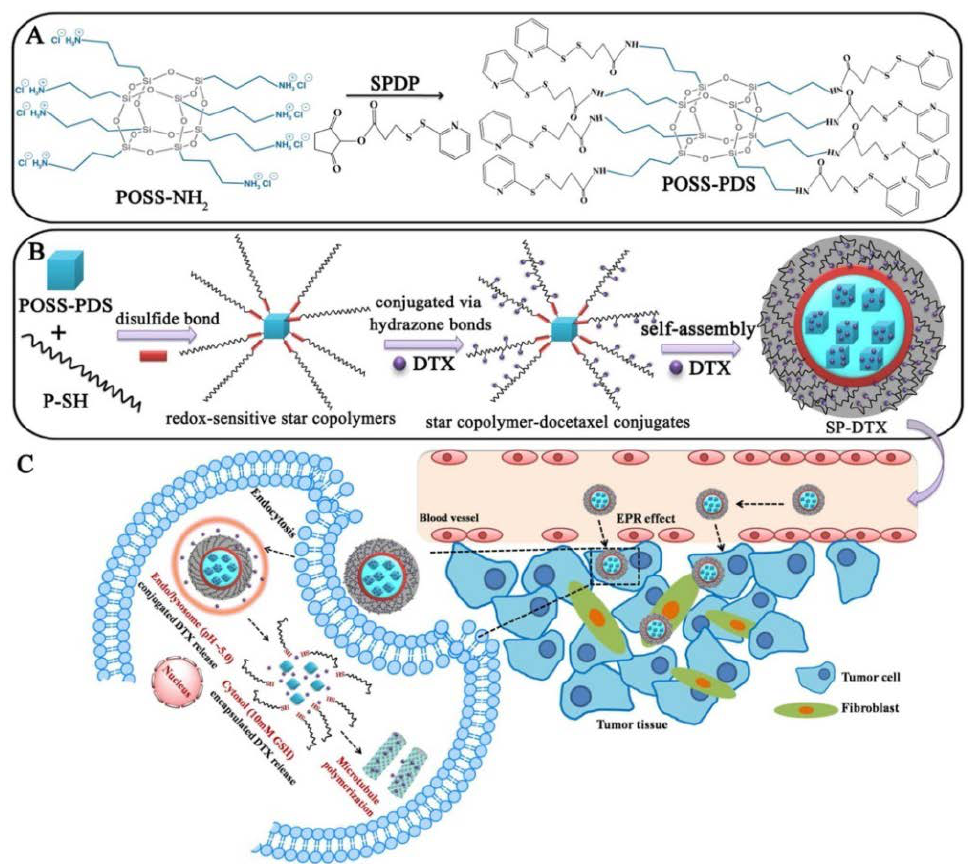
Figure 12. Schematic illustration of ( A ) the synthesis procedure of pyridyldisulfanyl-functionalized POSS (POSS-PDS). ( B ) Self-assembly of SP-DTX nanoparticles from amphiphilic star-shaped POSS-based conjugates. ( C ) Tumor accumulation and intracellular trafficking pathway of SP-DTX nanoparticles. SPDP represents for N -succinimidyl 3-(2-pyridyldithio) propionate. Reprinted with permission from [124]. Copyright (2016) American Chemical Society.